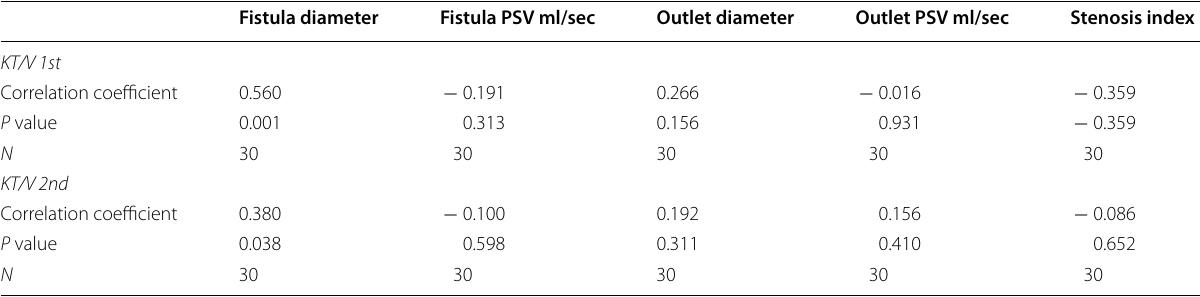
Table 4 Relation between AVF Doppler examination parameters and dialysis adequacy index (Kt/v)